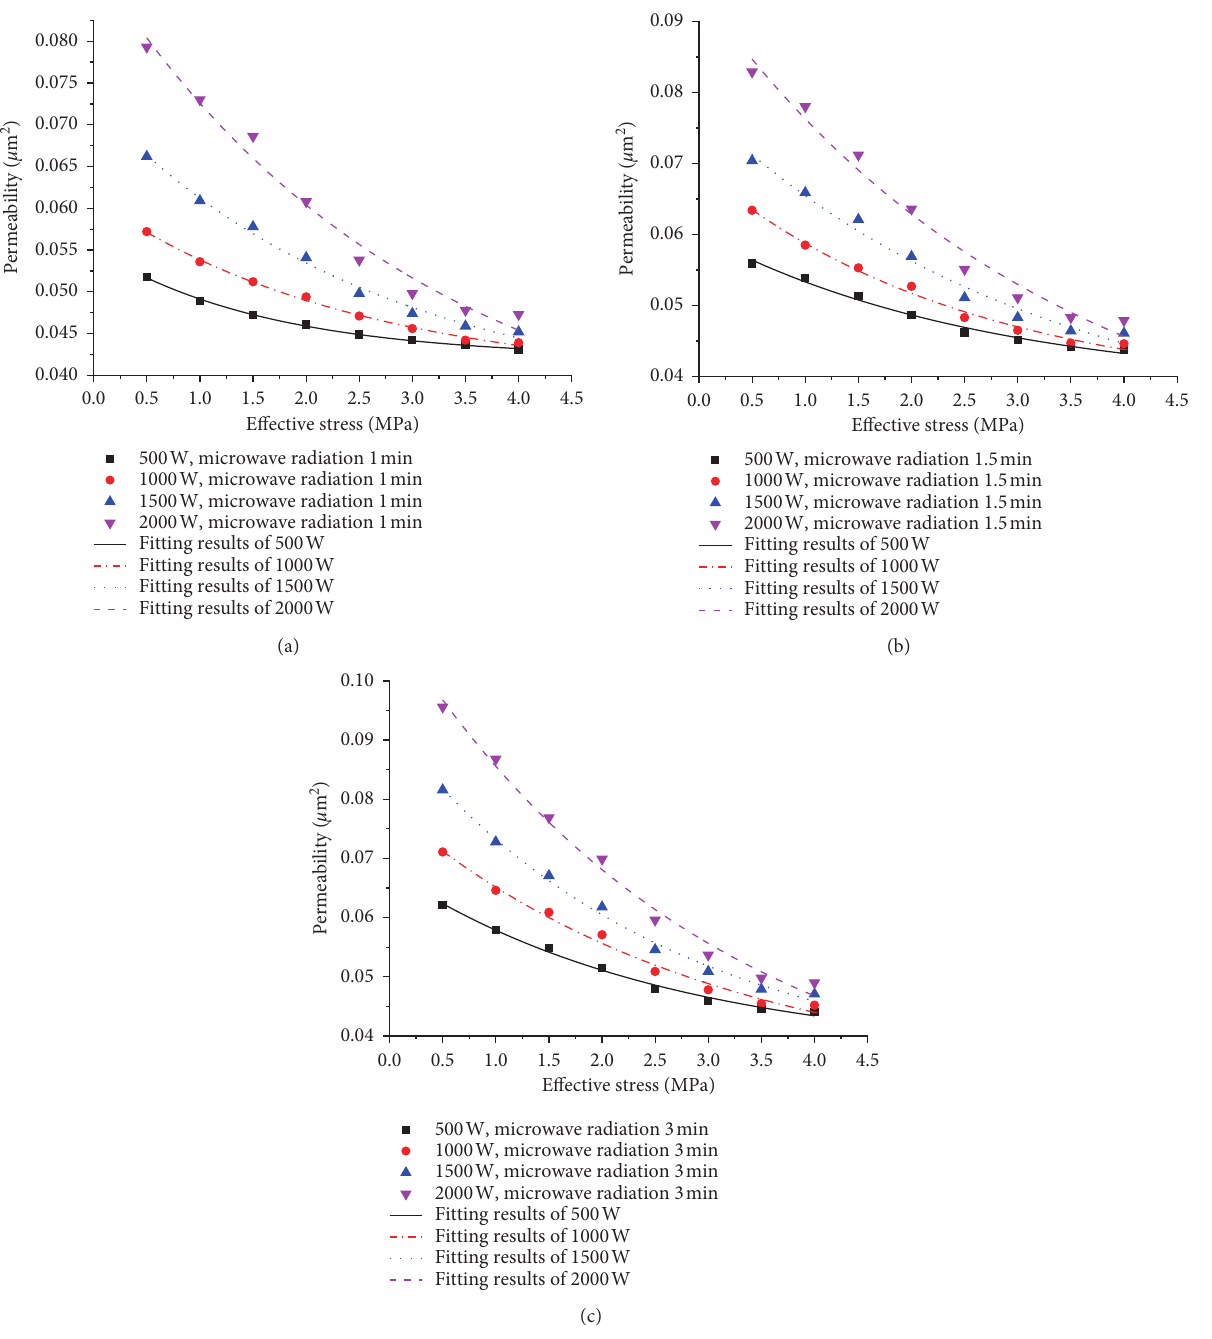
Figure 8: Effect of microwave power on the permeability at a confining pressure of